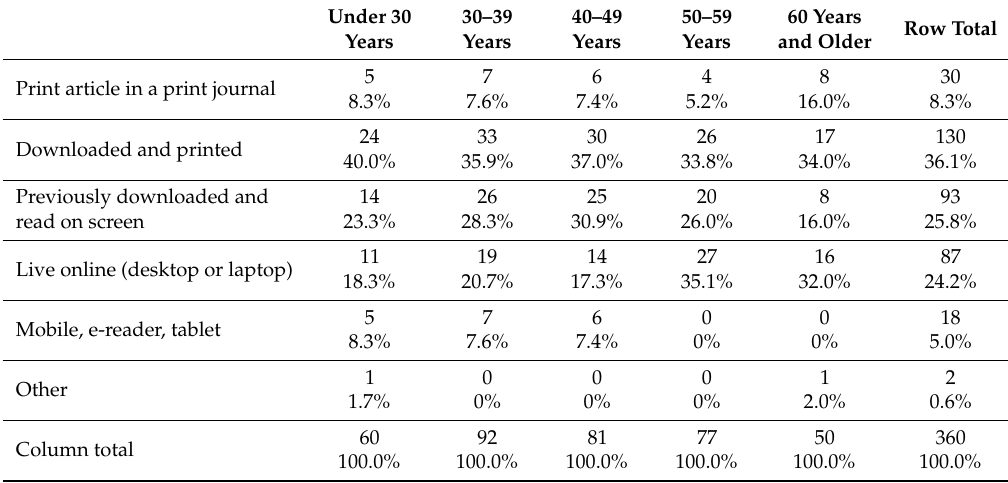
Table 20. Format of article reading by age